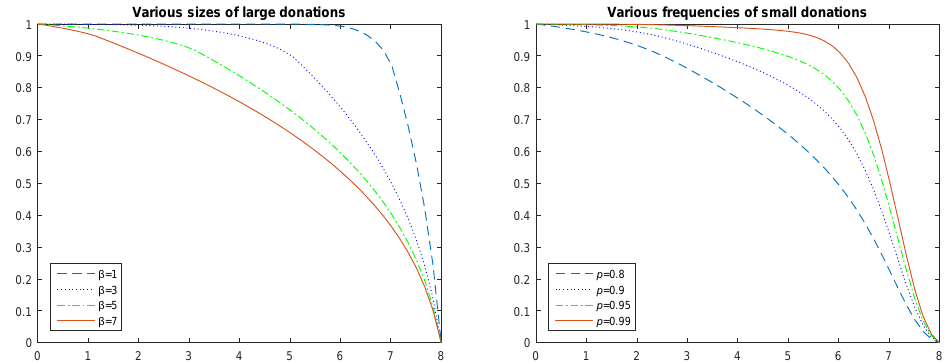
Figure 4. ( a ) (Left) Ruin probabilities for various sizes of large donations, for fixed γ = 0.1 and p = 0.85. ( b ) (Right) Ruin probabilities for various frequencies of small donations, for fixed γ = 0.5 and β =